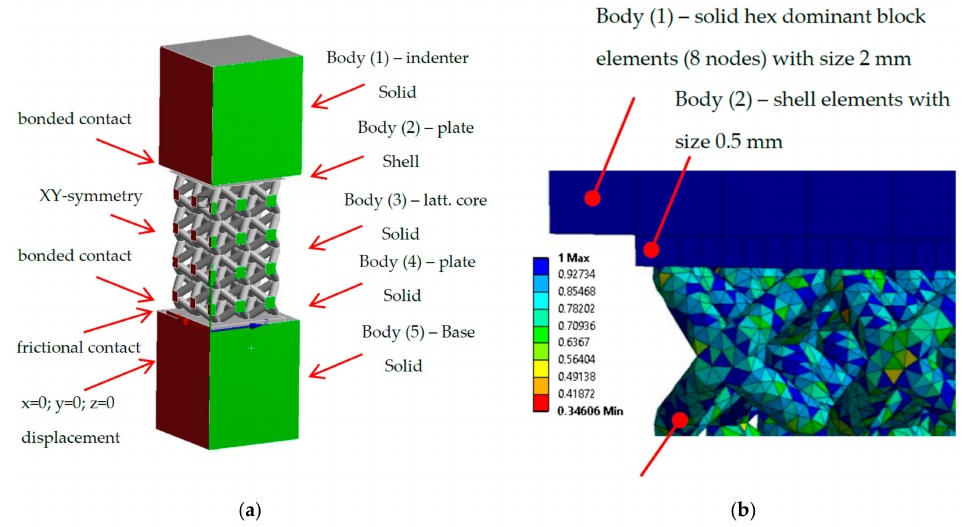
Figure 7. Numerical model in the Ansys software ( a ) quarter model with bodies and constrains; ( b ) finite element mesh quality.